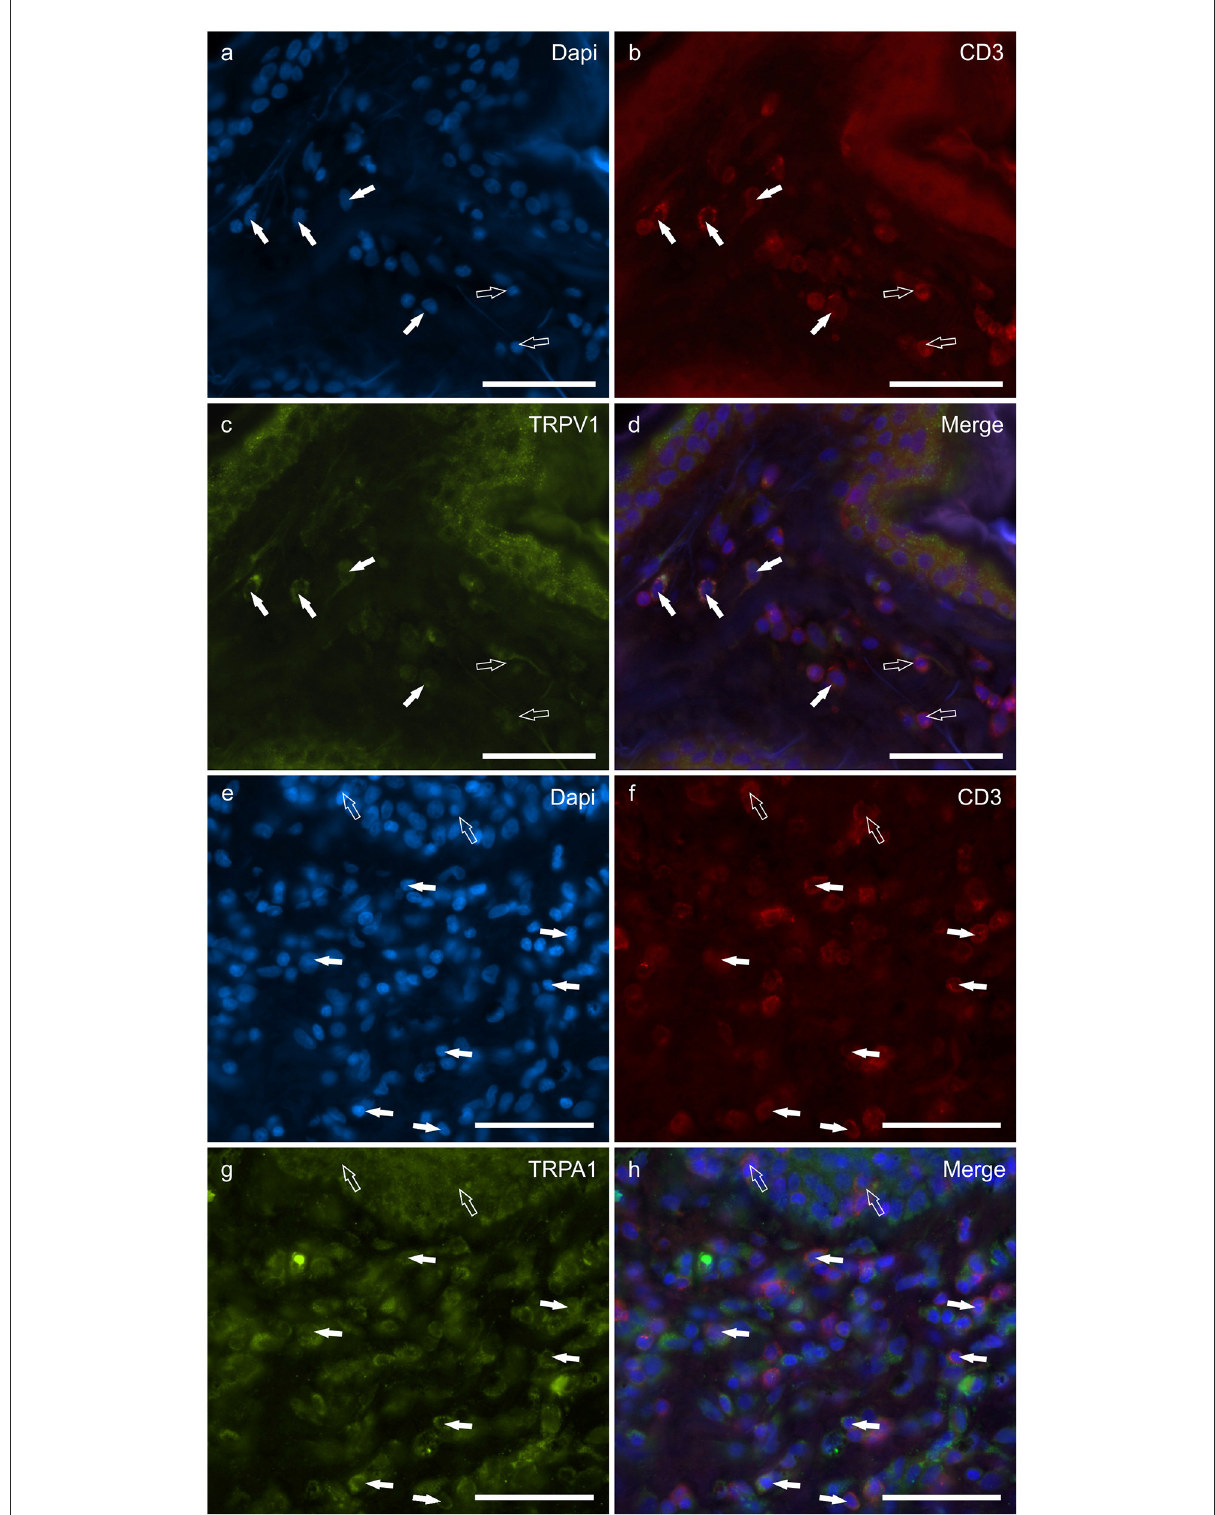
FIGURE7 Photomicrographs of the cryosections of the skin of dogs with atopic dermatitis (AD) showing CD3 immunoreactive T lymphocytes expressing transient receptor potential vanilloid 1 (TRPV1) (a–d) and transient receptor potential ankyrin 1 (TRPA1) (e–h) immunoreactivity (IR). (a–d) The white arrows indicate the dapi-labeled nuclei of some CD3 immunoreactive T lymphocytes co-expressing TRPV1-IR (C) . The open arrows